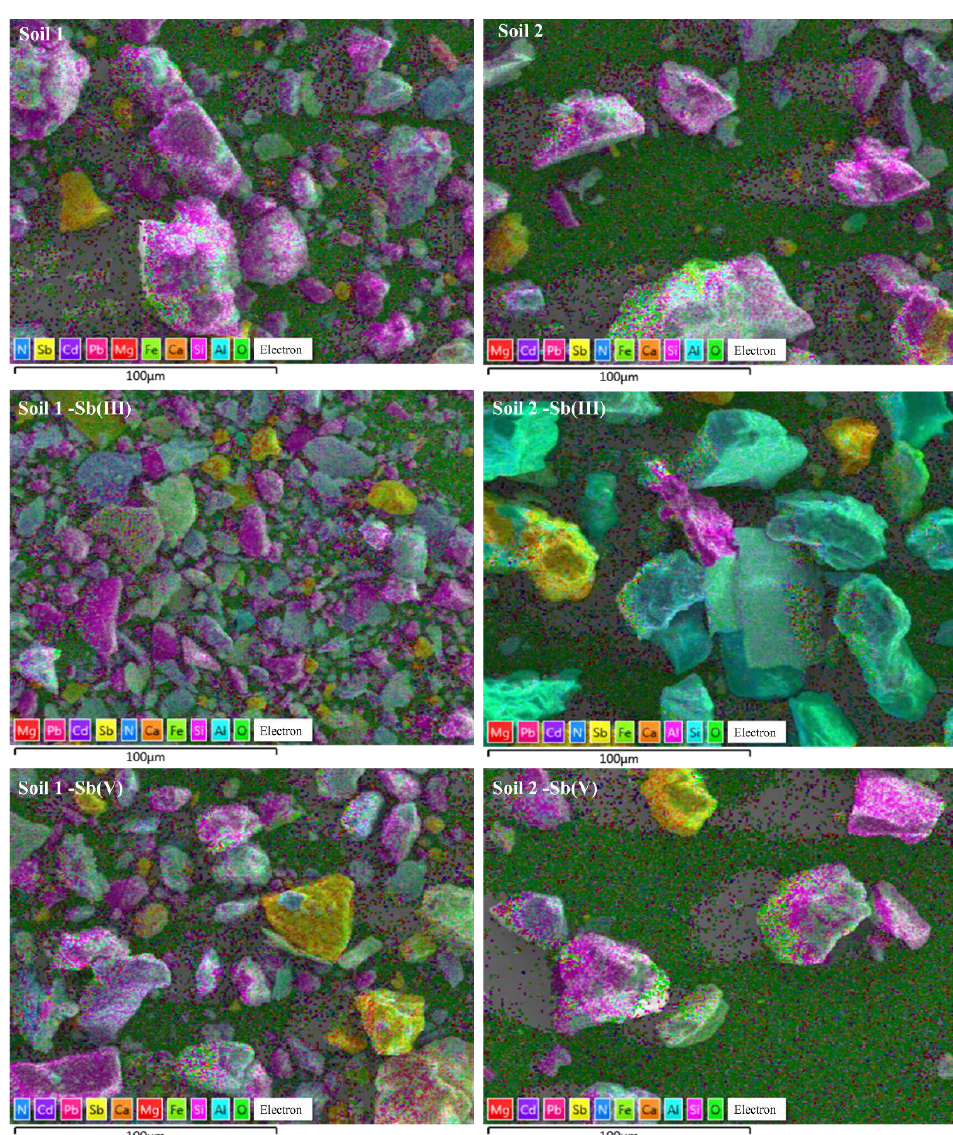
Int. J. Environ. Res. Public Health 2022 , 19 , x FOR PEER REVIEW Figure 8. Scanning Electron Microscope (SEM) mapping of Sb on soils. Figure 8. Scanning Electron Microscope (SEM) mapping of Sb on soils. To better understand the adsorption behavior of Sb, its surface chemical binding states in soils were analyzed through XPS results. It was clearly seen from Figure 9 that before Sb (III) and Sb (V) adsorption, XPS spectrums of soil 1 and soil 2 could be divided into Sb3d5 at the peak of 530.7 ev. After the adsorption, the XPS spectrum of the soils could be deconvoluted into Sb3d3 and Sb3d5, representing Sb (III) and Sb (V) at the peaks of 530.7 ev and 540.1 ev. The results implied that the redox reactions might accompany the changes in Sb valences during the adsorption. The reduction of Sb (V) to Sb (III) in soils has been shown to occur with the ferrous iron [59], while the oxidation is enhanced by Fe/Mn oxyhydroxides present in natural soils [46] and the reactive oxygen species (ROS), including hydroxyl (·OH), peroxyl radicals (·ROO), hydrogen peroxide (H 2 O 2 ), and superoxide radical anion (·O 2− ) in groundwater [60]. Besides, pH had an effect on the redox rate of Sb [31,35,36].